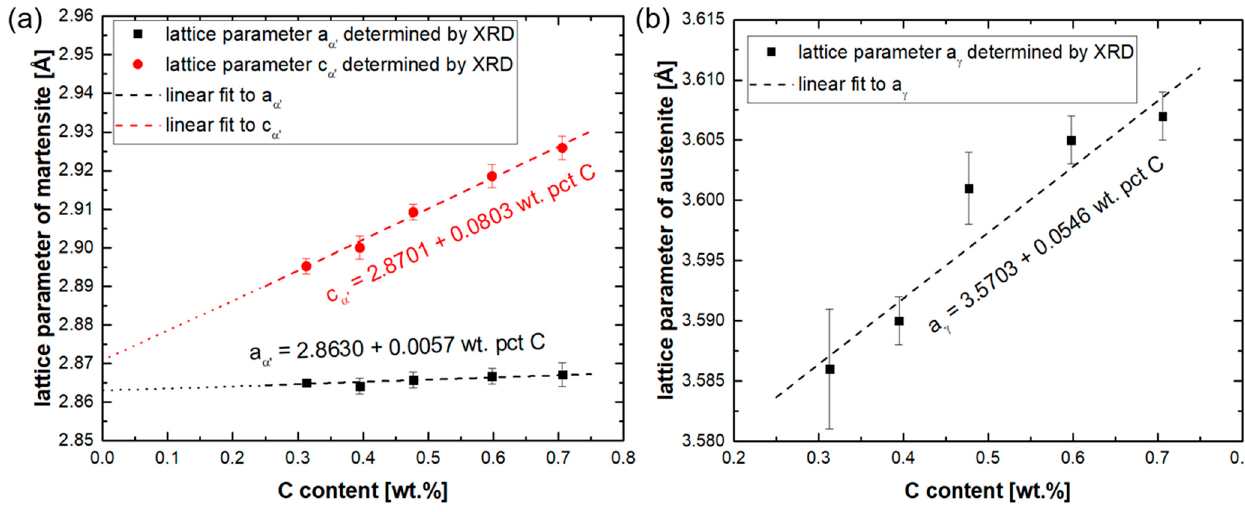
Figure 11. ( a ) Lattice parameters a α (cid:48) and c α (cid:48) of martensite as a function of the carbon content; ( b ) lattice parameter of austenite a γ as a function of the carbon content.